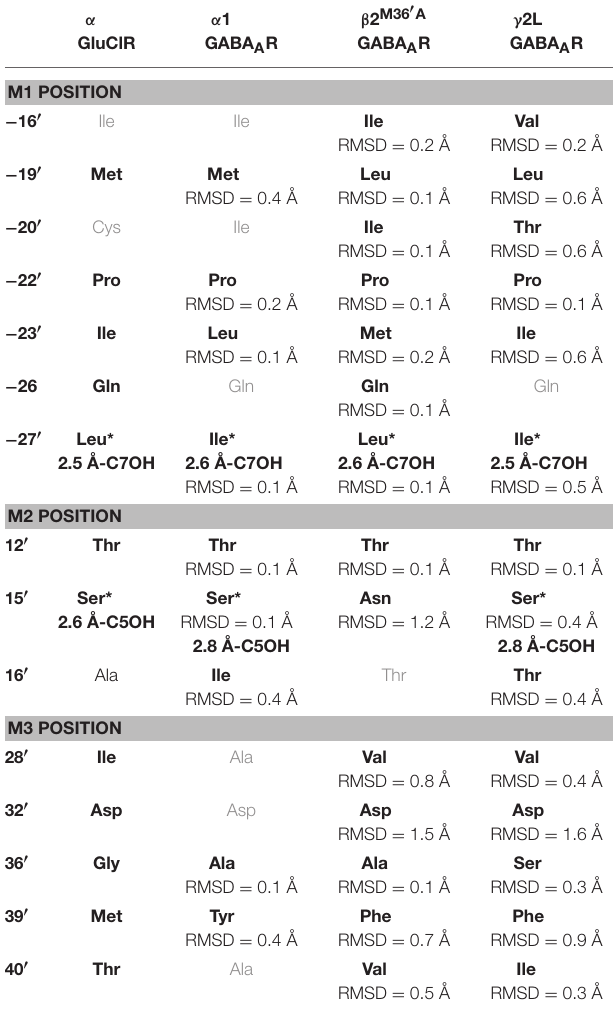
TABLE 2 | Transmembrane residues predicted to contribute to ivermectin sensitivity in the C. elegans α GluClR and the human α 1 β 2 M36 GABA A